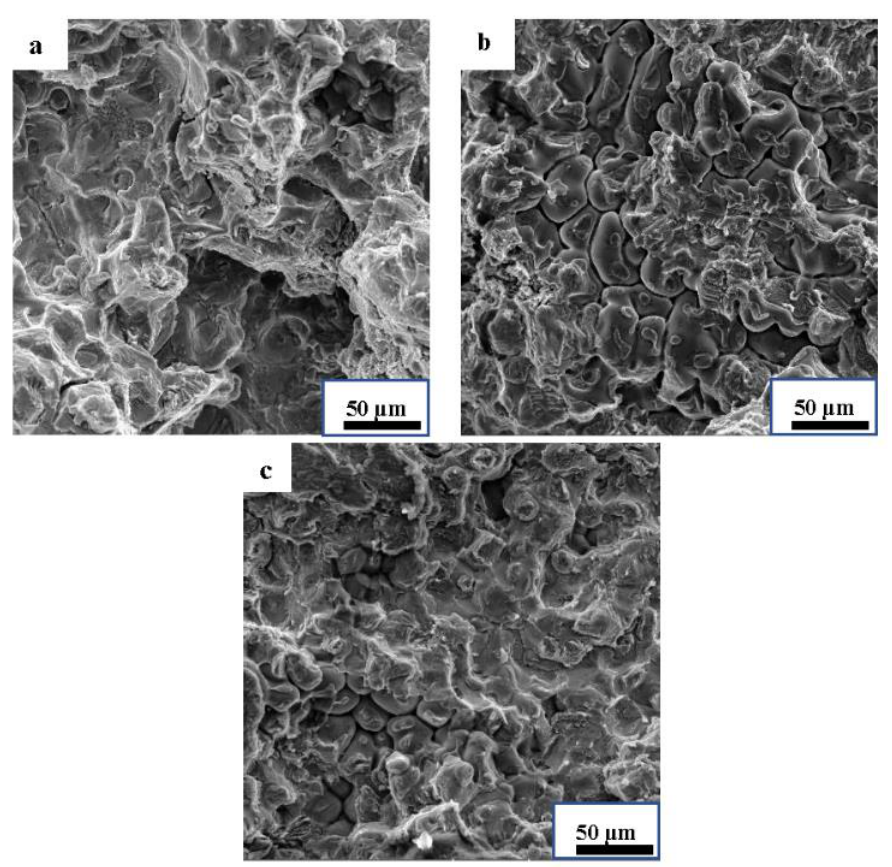
Fig. 9. (a)-(c) SEM fractography of tensile tested Al 7075 and Al 7075 –TiC composites (a) Al 7075-wt.% TiC; (b) Al 7075-wt.% TiC; (c) Al 7075-9wt.% TiC